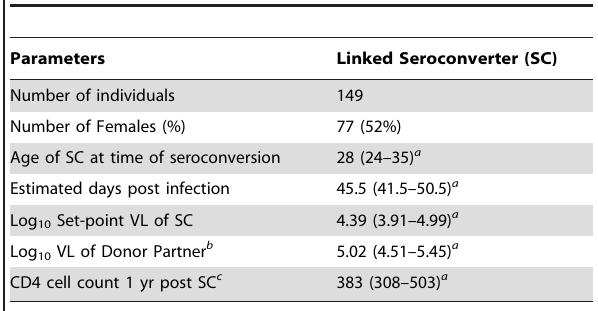
Table 1. Cohort statistics generated from the 149 transmission pairs selected from the ZEHRP cohort.